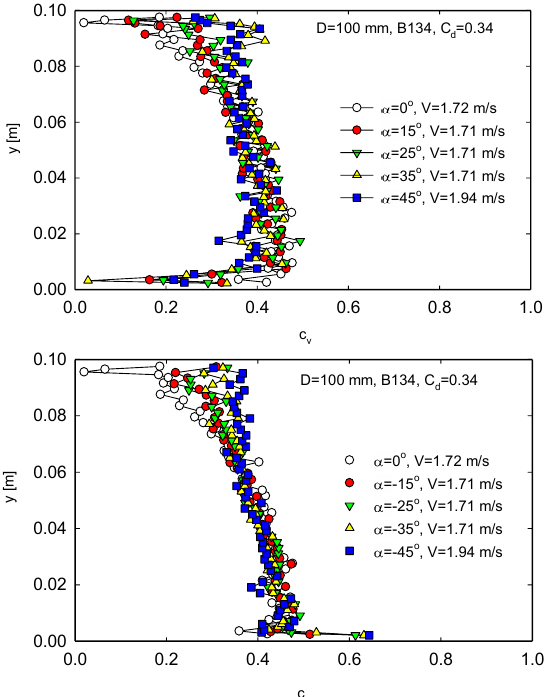
Fig. 6. Effect of the pipe inclination α ( C d = 0.12).